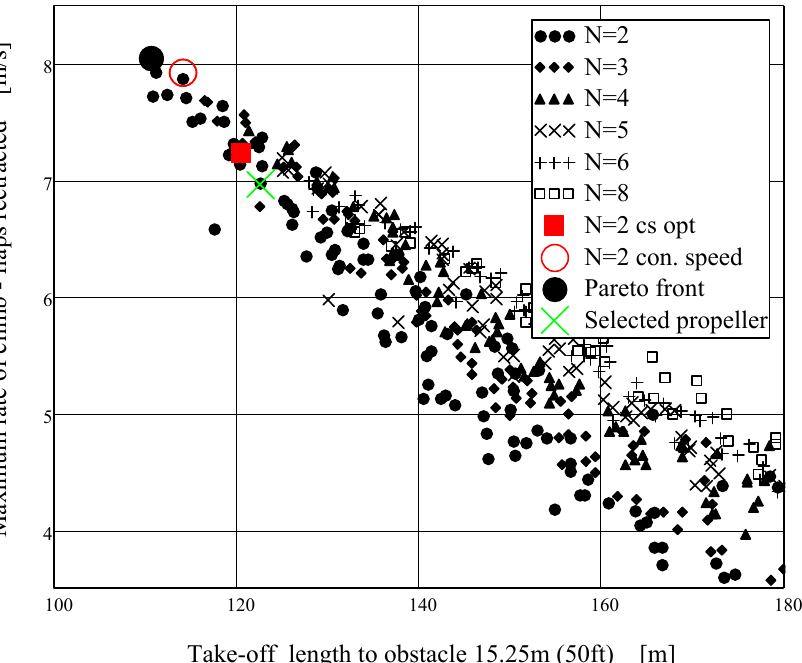
Figure 10. Pareto frontier for take-off distance (take-off engine regime) and maximum rate of climb (take-off engine regime). Table 5. Point on the Pareto front for take-off distance (take-off engine regime) and maximum rate of climb (take-off engine regime) (see Figure 10).